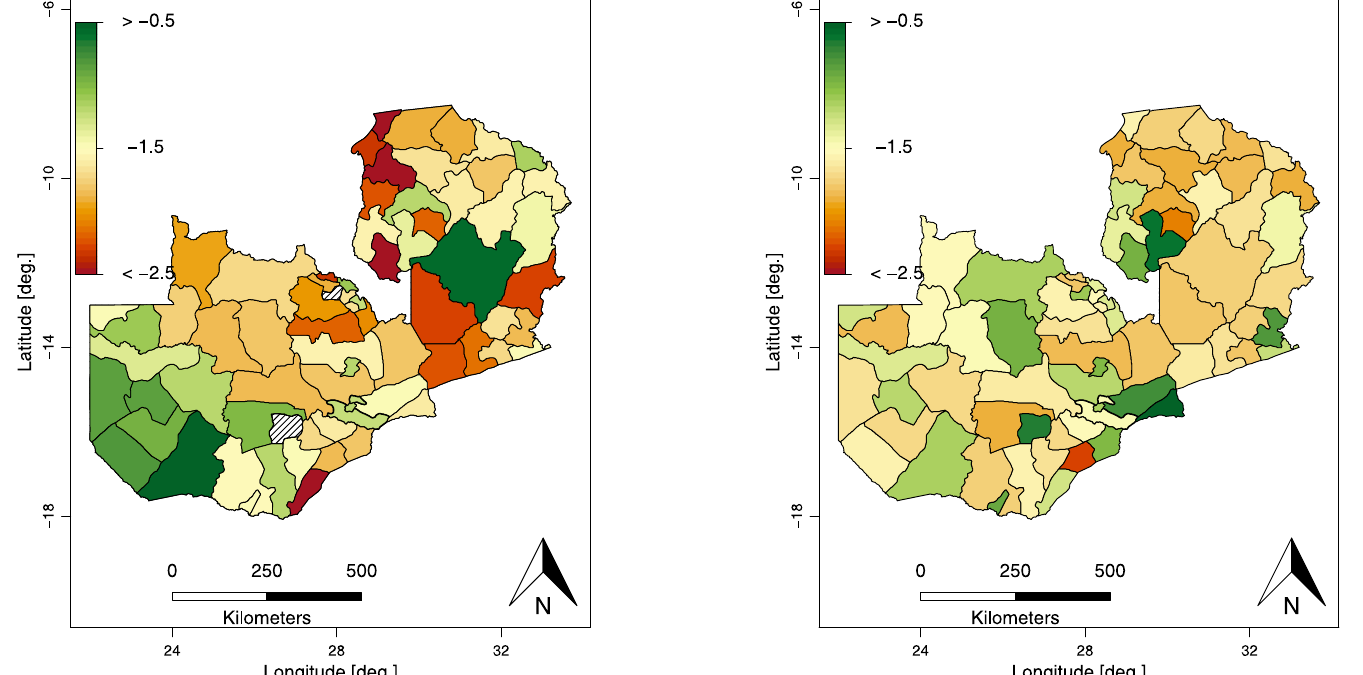
Fig 1. Levels of stunting over time in Zambia. The panel shows the average height-for-age z-score at district level for 2007 (left) and 2013/14 (right) of Zambia. Source : Demographic and Health Surveys (data) and Database of Global Administrative Areas (boundary information); calculation by authors. The shapefile used to create these maps is republished from [54] under CC BY license, with permission from Robert J. Hijmans, original copyright [2021].